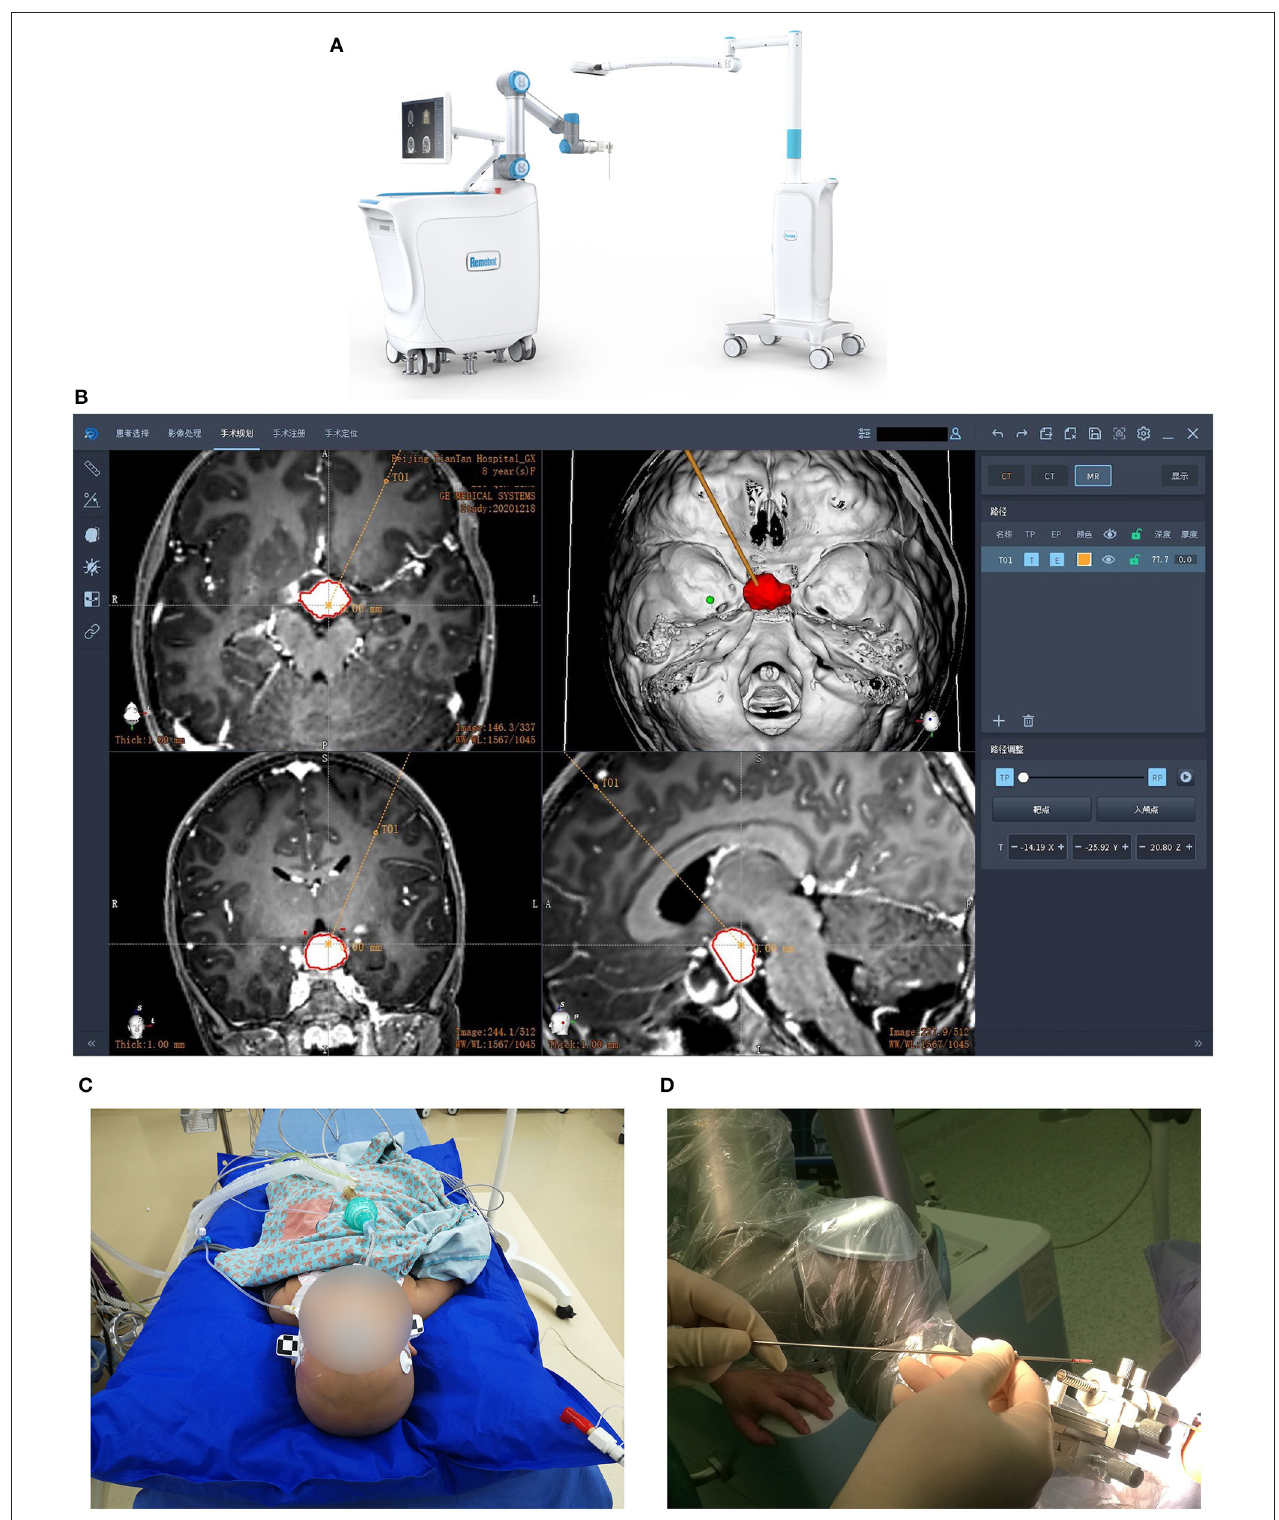
FIGURE 1 | Images of the Remebot and surgical workflow. (A) The Remebot device comprises a videometric tracker, a planning station, and a robotic arm. (B) The trajectories were planned according to the fusion of preoperative MRI and CT images. (C) The videometric tracker scanned the optical marker pasted on the patient’s head to complete registration. Local anesthesia for most patients while general anesthesia for children and some uncooperative patients. (D) Biopsies were taken at multiple points.